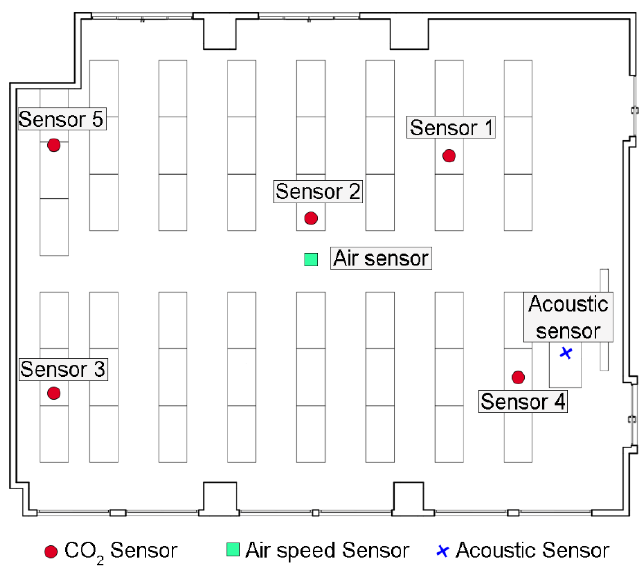
Figure A1. Classroom layout and field measurement configuration.